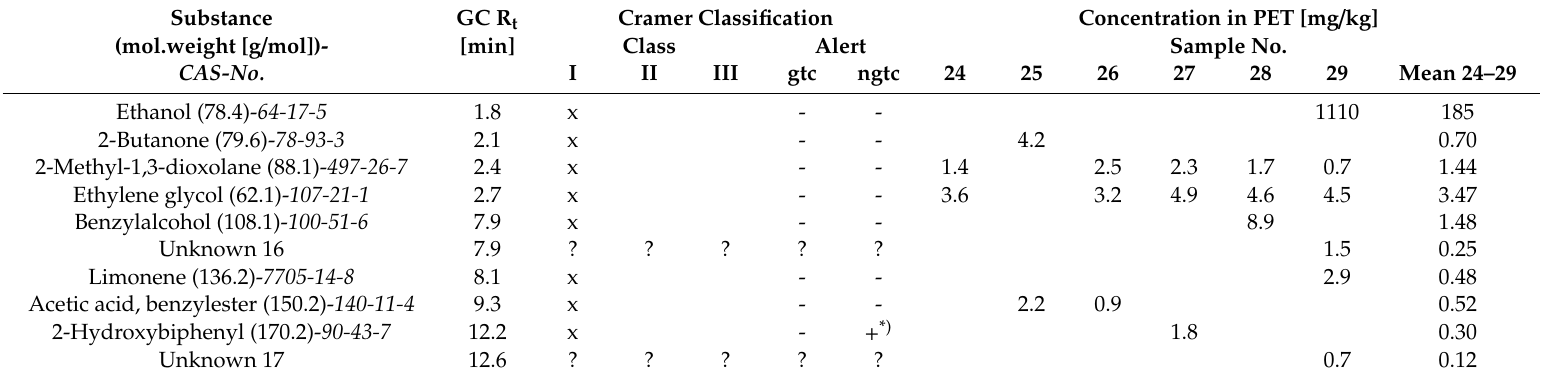
Table 5. Substances found in PET bottles originally used for shampoo